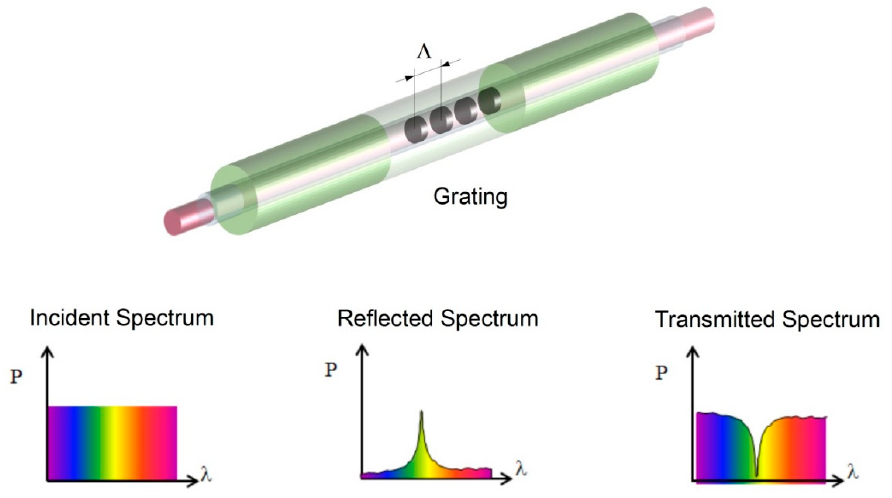
Figure 2. Fibre Bragg grating schematic representation.